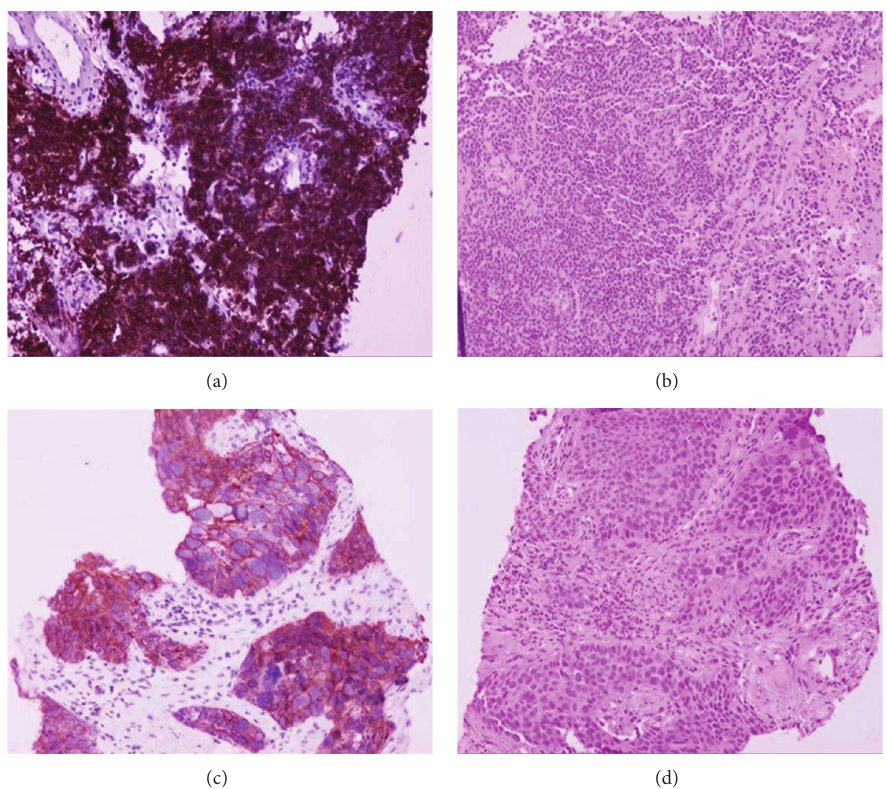
Figure 2: CT-guided histologic biopsy of the left lower lobe mass on immunohistochemical stain CD20 × 200 (a) and on H-E × 200 (b) reveals B-cell, mucosa-associated, non-Hodgkin lymphoma of the BALT type. CT-guided histologic biopsy of the middle lobe mass on immunohistochemical stain cyto34BE 12 × 200 (c) and on H-E × 200 (d) discloses lung cancer from squamous